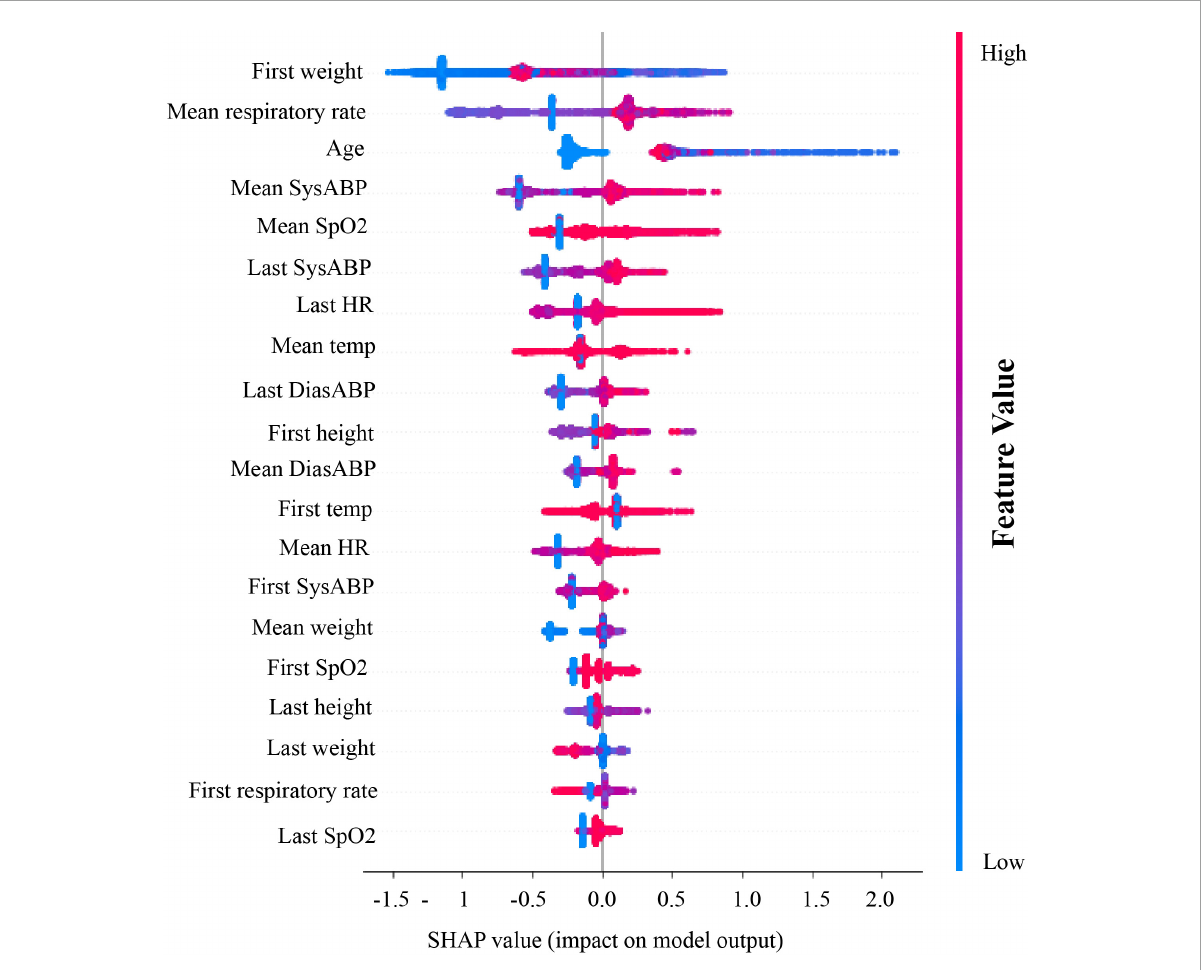
FIGURE3 Shapley value plots for degree of model’s dependence on specific features. From top to bottom, the relative importance of each feature was ranked. Red dots represent relatively high values of a feature and blue dots represent relatively low values. On the x-axis, the SHAP values (or impact on model output) is plotted. If most of the red dots are on the right of the x-axis, it means high value of that feature (ex. mean DiasABP in this figure) substantially contributes to a positive prediction. SysABP, systolic arterial blood pressure; DiasABP, diastolic arterial blood pressure; RespRate, respiratory rate; HR, heart rate; SpO2, oxygen saturation; Temp, body